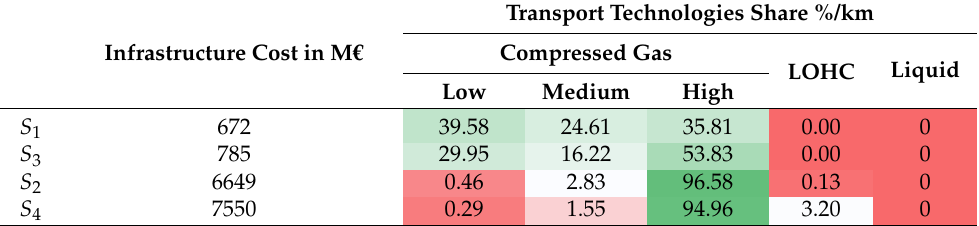
Table 6. Different scenarios results cost and transport